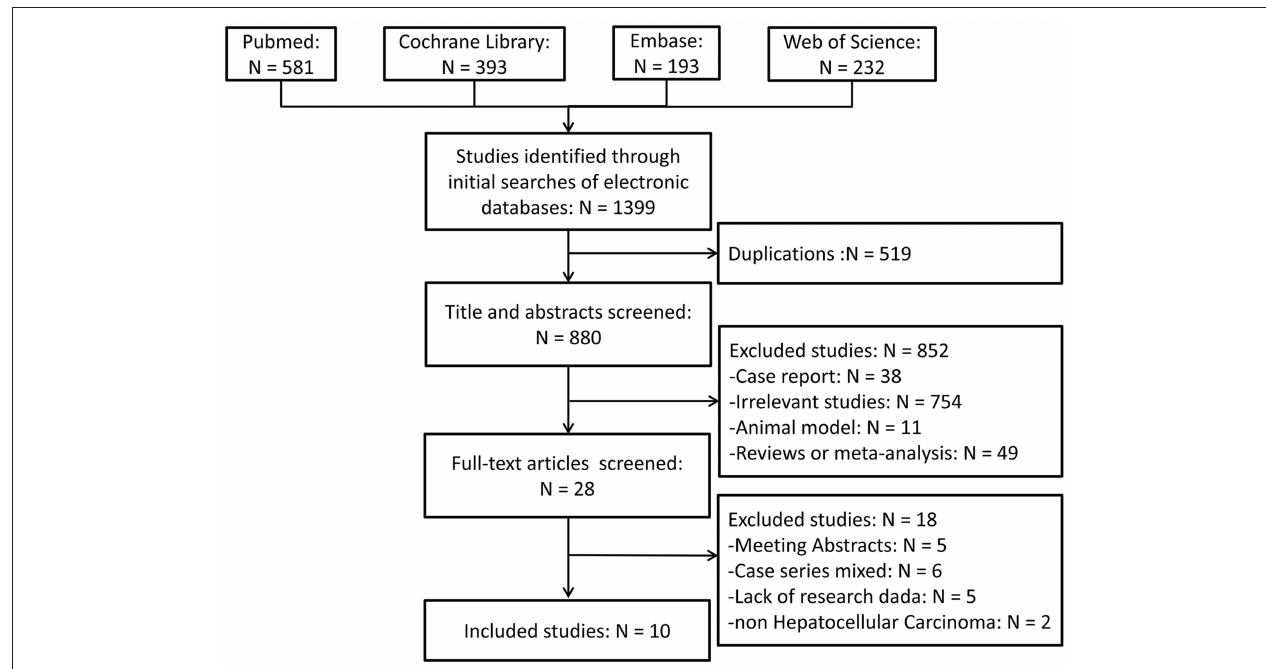
FIGURE 1 | Schematic illustration of the literature search and study-selection criteria.